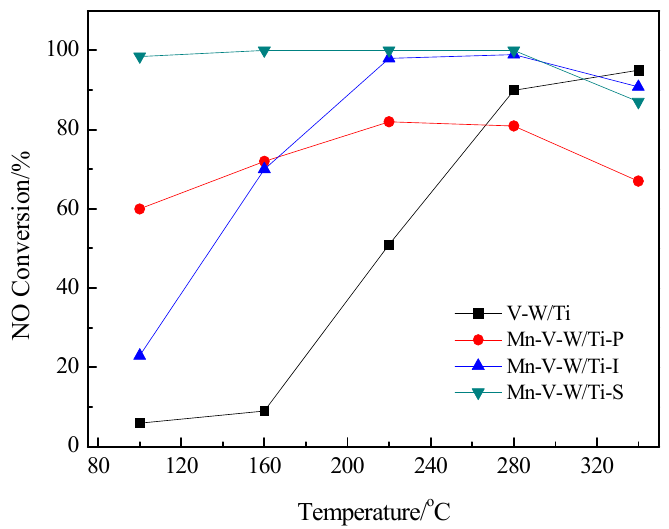
Figure 2. The effect of different preparation methods on catalyst activity. Reaction conditions: [NO] = [NH 3 ] = 600 ppm, [O 2 ] = 3 vol.%, N 2 as the balance gas, total flow rate = 350 mL · min − 1 .